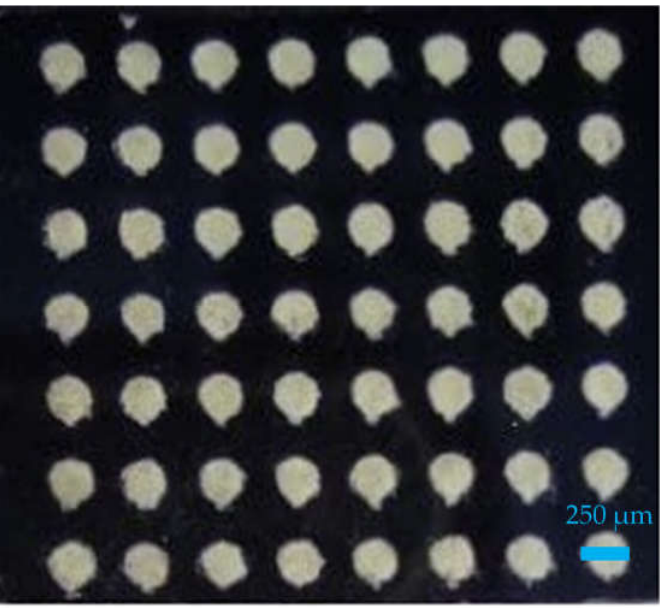
Figure 1. Ferrite plate with periodical holes and introduced glass-ceramic composite in